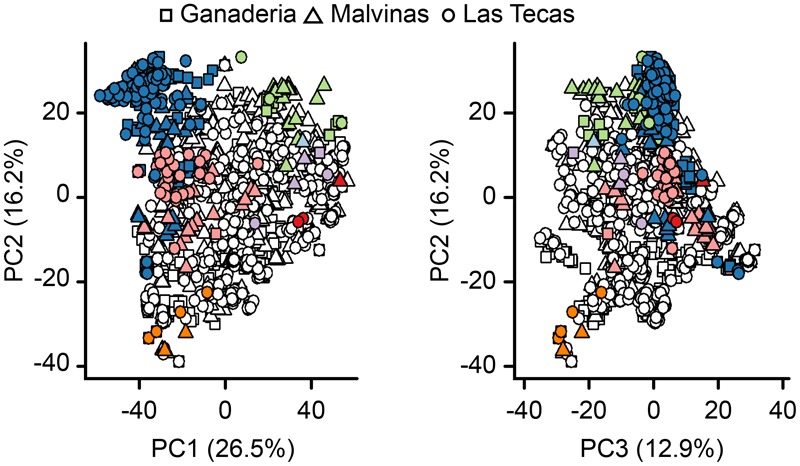
Principal component analysis (PCA) of genetic relatedness of 1,345 cacao individuals in three sites using a genome-wide panel of 9,640 SNPs. Shapes refer to the population of the individual. Colored points are individuals showing >0.5 proportion ancestry of an ancestral group (see Figure 2 for description). Percentage of the variation captured by each component is given on the axis labels.